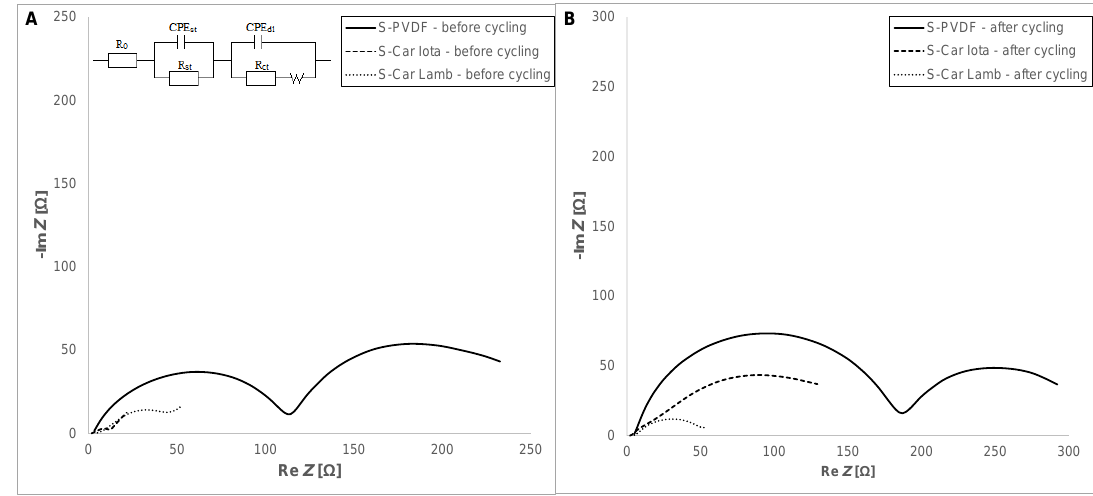
Figure 4. The electrochemical impedance spectra for the S-PVDF, S-Car-Iota, and S-Car-Lamb electrodes: ( A ) before cycling, ( B ) after cycling.